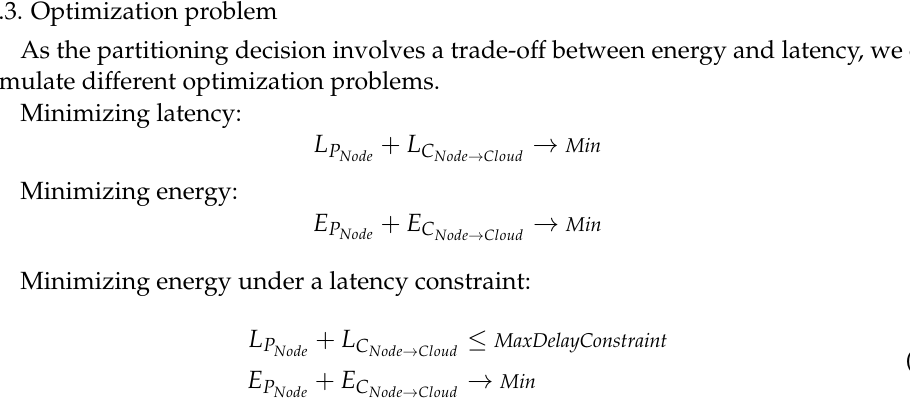
Figure 10. Latencies of the partitions along the system as a function of the number of objects for an image size of 2848 × 4288 ×